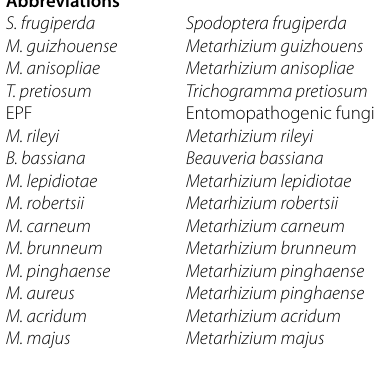
The different lowercase letters within the same column and the different uppercase letters within the same row indicate significant difference at 0.05 level ( p < 0.05)